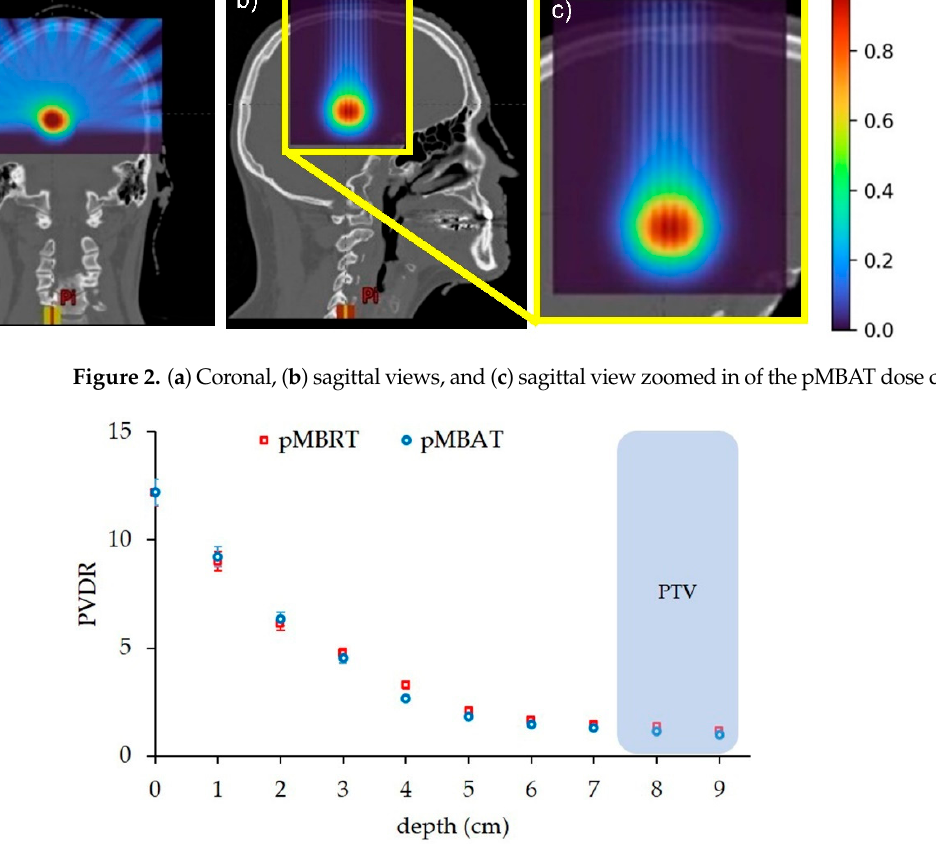
Figure 3. PVDRs at different depths along the beam path in the standard pMBRT (single array) and pMBAT (multi-array) scenarios.